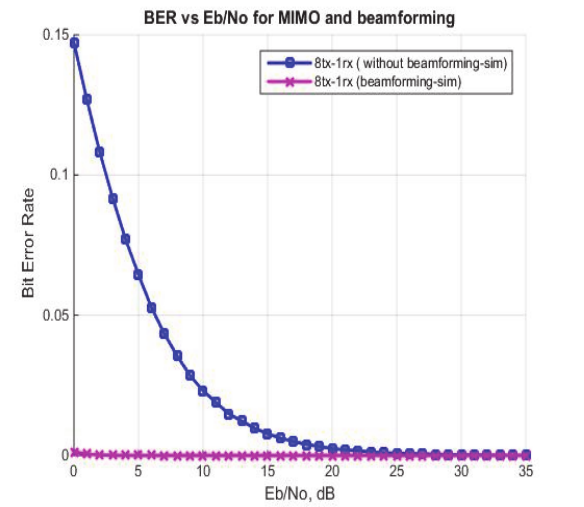
Fig. 5. BER vs E b / N o for 8 × 1 MIMO systems with and without